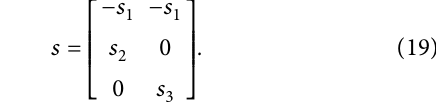
Figure 2: Timing design adopted for two-phase signal